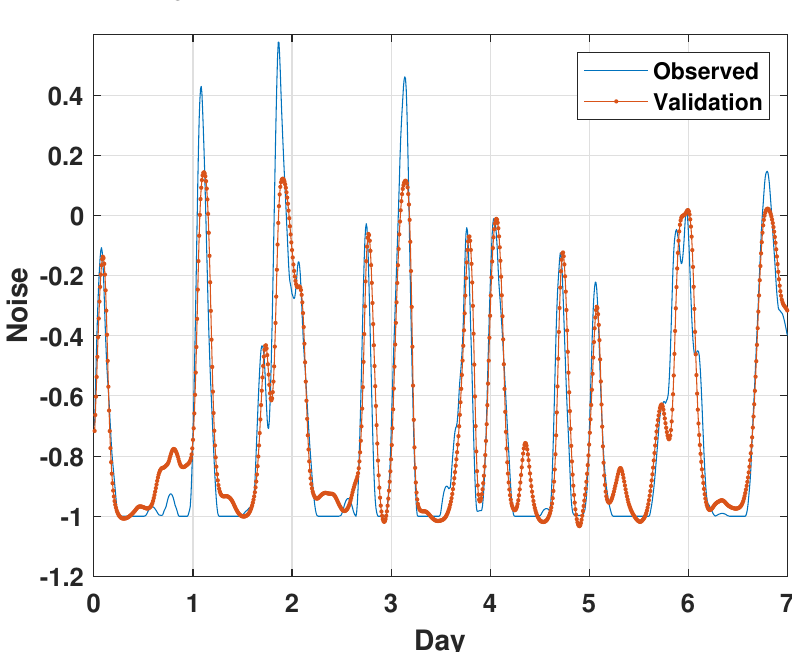
Figure 7. Training and validation of the noise